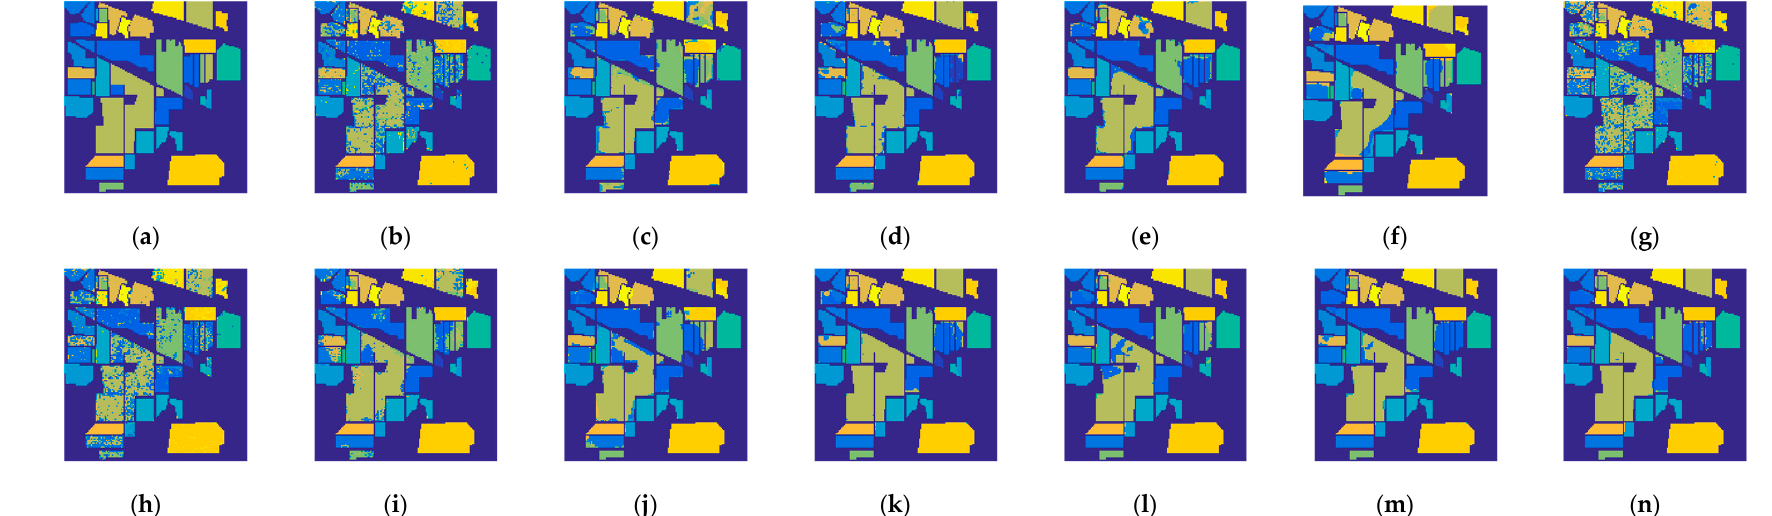
Figure 3. Results for the Indian Pines dataset with about 30 training samples per class: ( a ) Ground truth. ( b ) KSVM (OA = 74.42). ( c ) SVM-CK (OA = 85.93). ( d ) FF-SVM (OA = 90.63). ( e ) JDFFF-SVM (OA = 91.54). ( f ) SMLR-SPATV (OA = 89.10). ( g ) GELM (OA = 66.85). ( h ) KELM (OA = 74.37). ( i ) GELM-CK (OA = 88.86). ( j ) KELM-CK (OA = 91.96). ( k ) GELM-FF (OA = 94.23). ( l ) KELM-FF (OA = 94.93). ( m ) GELM-JDFF (OA = 94.93). ( n ) KELM-JDFF (OA = 95.13).